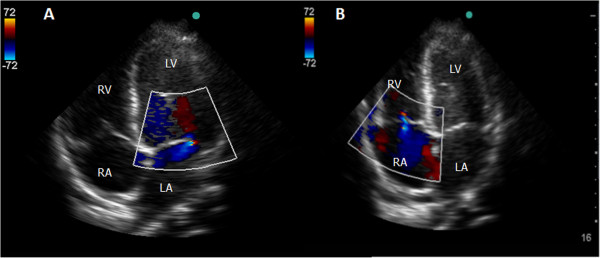
Valvular regurgitation. A- Mild MR by color Doppler (apical 4-chamber view). B- Moderate TR by color Doppler (apical 4-chamber view). LA, left atrium; LV, left ventricle; RA, right atrium; RV, right ventricle.